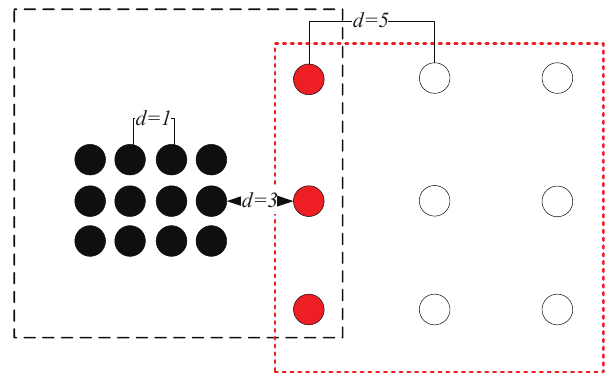
Figure 3. Illustration of the problem in the traditional agglomerative hierarchical